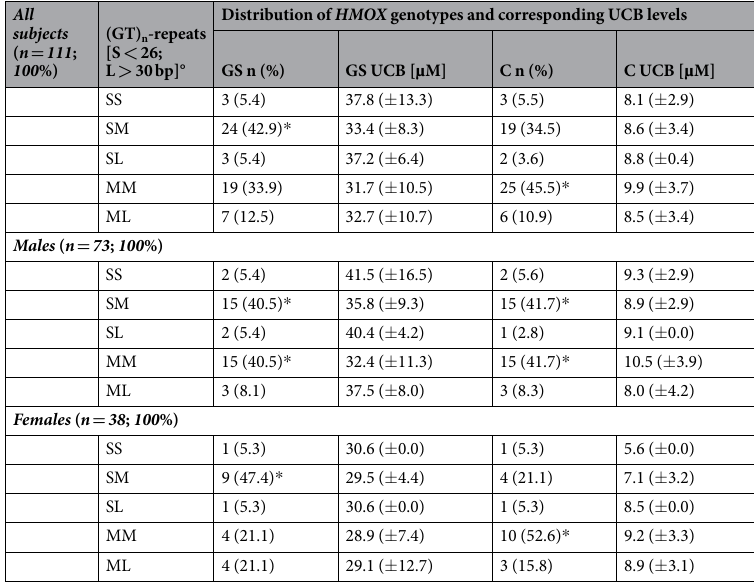
Table 2. Distribution of HMOX genotypes (GT fragment length) between the study groups (GS, C). Table 2 specifies the distribution of HMOX -genotypes in terms of GT fragment lengths (GT-repeats) in the respective study groups (all subjects and divided by gender), and the corresponding UCB levels (mean ± sd). No statistical significance was reached. However, non-significantly in GS subjects shorter alleles (SM) occurred more frequently than in C, where the MM genotype was more common. The effect was only present in females. UCB levels non-significantly decreased, as GT-repeats increased. °Cut-off levels for classification of GT fragment lengths were adopted from Chang et al . 72 . Abbreviations: SS: short/short; SM: short/medium; SL: short/long; MM: medium/medium; ML: medium/long GT fragment length (repeats); GS: Gilbert’s Syndrome; C: Controls. * Most frequently occurring genotype in respective